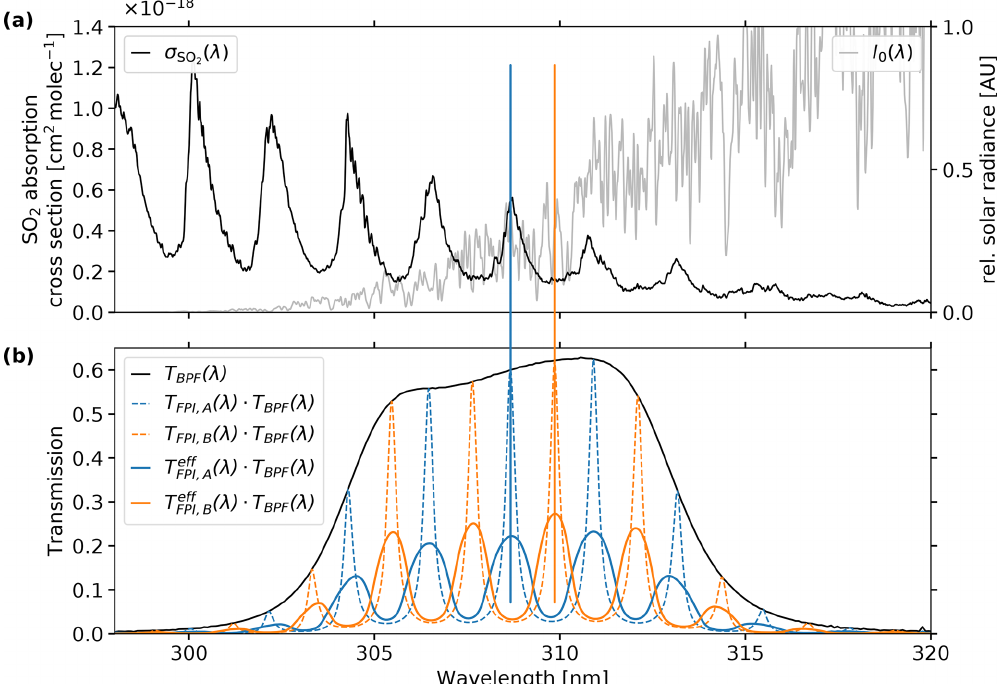
Figure 1. Spectral variation of (a) the SO 2 absorption cross section σ SO (black drawn, left axis, according to Bogumil et al., 2003) and the 2 scattered skylight radiance I 0 (λ) (grey drawn, right axis in relative units), given by Eq. (2). (b) The FPI transmissions in settings A and B yielding the maximum AA detectable (best correlation/anti-correlation to σ SO ) in the spectral range specified by the band pass filter used 2 (BPF). The BPF transmission T BPF (λ) (black) and the FPI transmission spectrum for a single-beam approach are shown according to Eq. (6) in on-band T FPI ,A (λ) (dashed blue, correlation with σ SO ) and off-band T FPI ,B (λ) setting (dashed orange, anti-correlation with σ SO ). The 2 2 (λ) (drawn blue) effective FPI transmission spectrum including an incident angle distribution is shown according to Eq. (7) in on-band T eff FPI ,A (λ) setting (drawn and off-band T eff FPI ,B